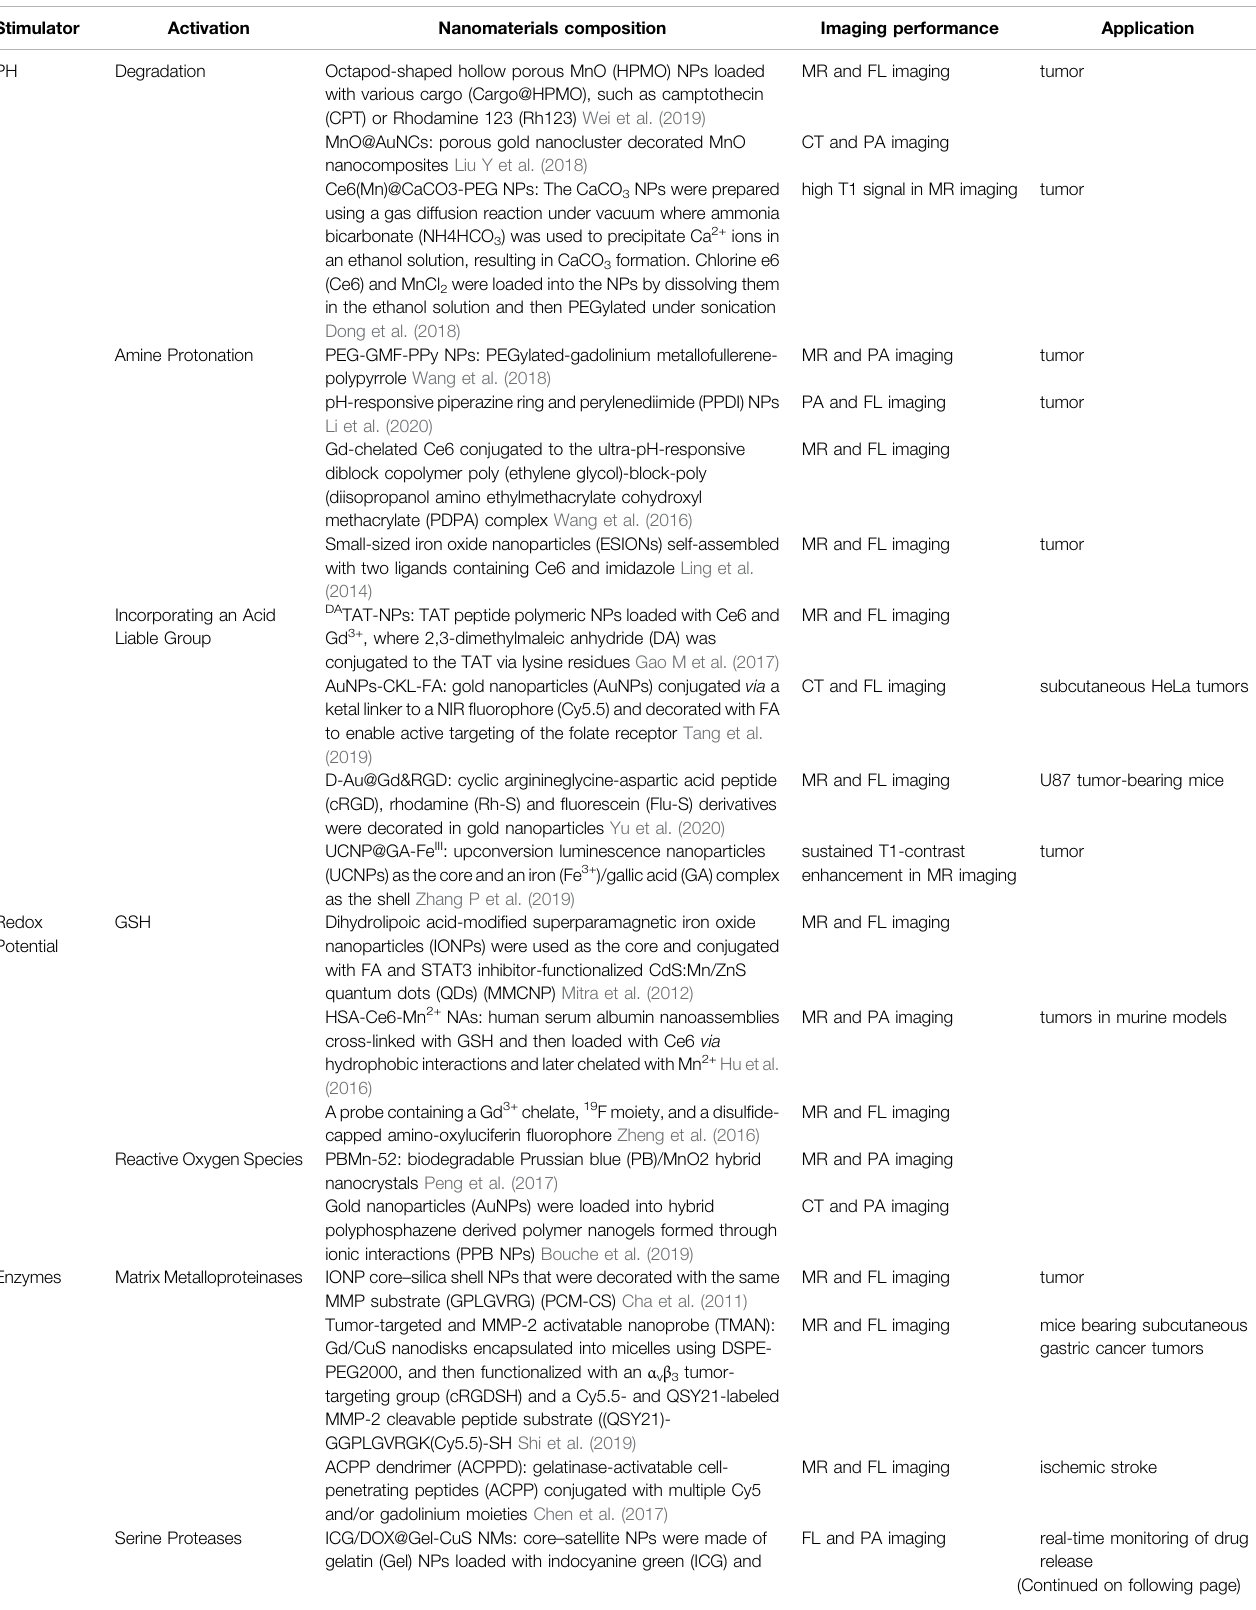
TABLE 1 | Internally responsive nanomaterials for imaging (some examples listed).